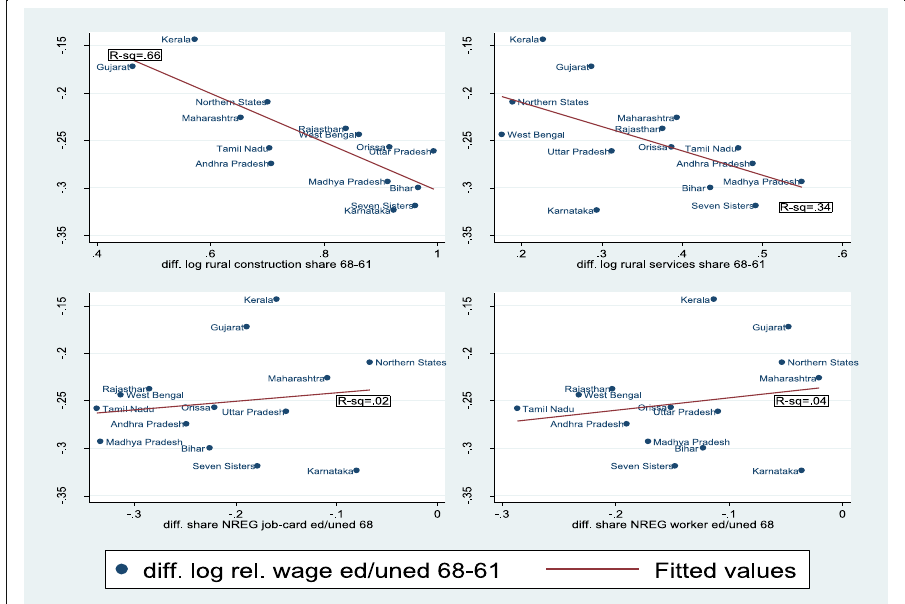
Fig. 9 Drivers of changes in educated vs. uneducated wages within rural